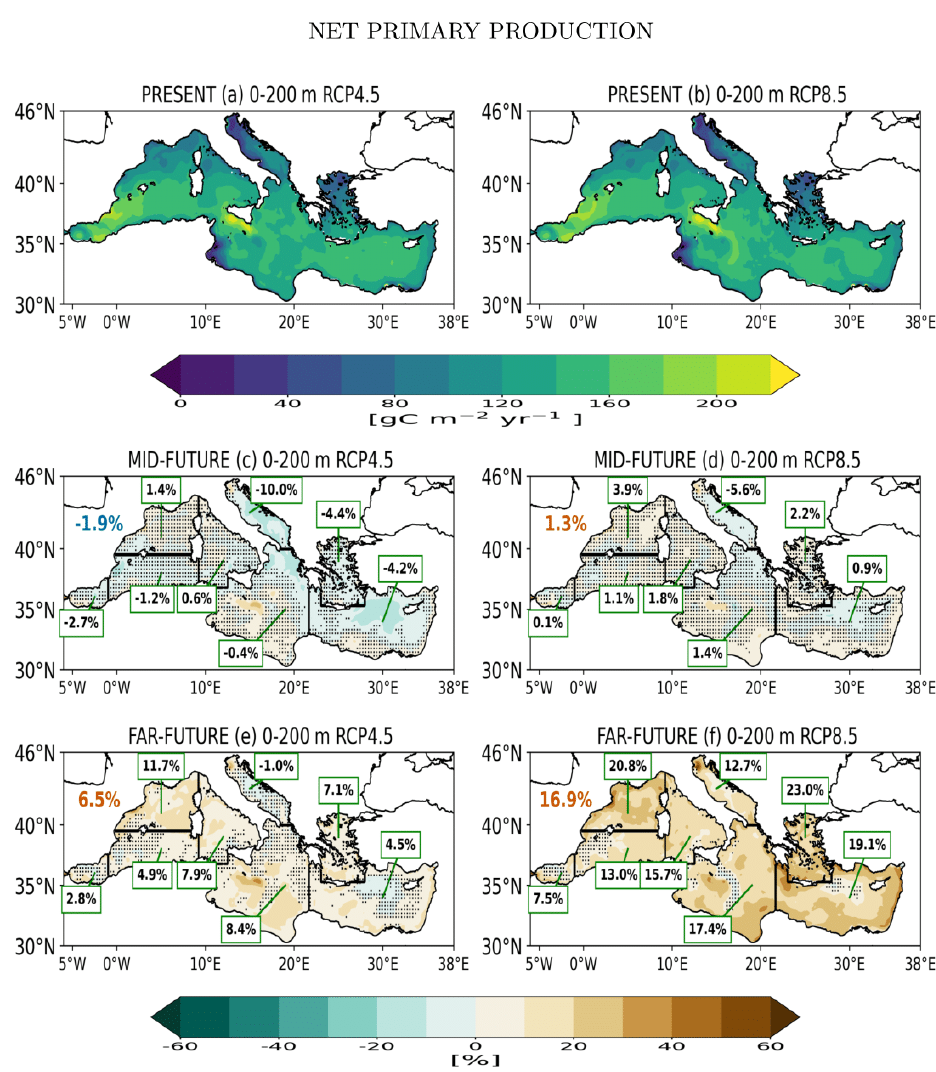
Figure 11. Integrated net primary production (in gCm − 2 yr − 1 ) in the first 200m in the PRESENT (2005–2020, a , b ) and the relative climate change signal (with respect to the PRESENT, in %) in the MID-FUTURE (2040–2059, c , d ) and FAR-FUTURE (2080–2099, e , f ) in the RCP4.5 (a, c, e) and RCP8.5 (b, d, f) scenarios. The Mediterranean average relative climate change signal in each period (with respect to the PRESENT) is displayed as a colored value (blue or dark orange when negative or positive, respectively) in the top left of the subfigure. Values in green boxes are average relative climate change signals for particular periods and sub-basins shown in Fig. 1. Domain grid points where the relative climate change signals are not statistically significant according to a Mann–Whitney test with p< 0 . 05 are marked by a